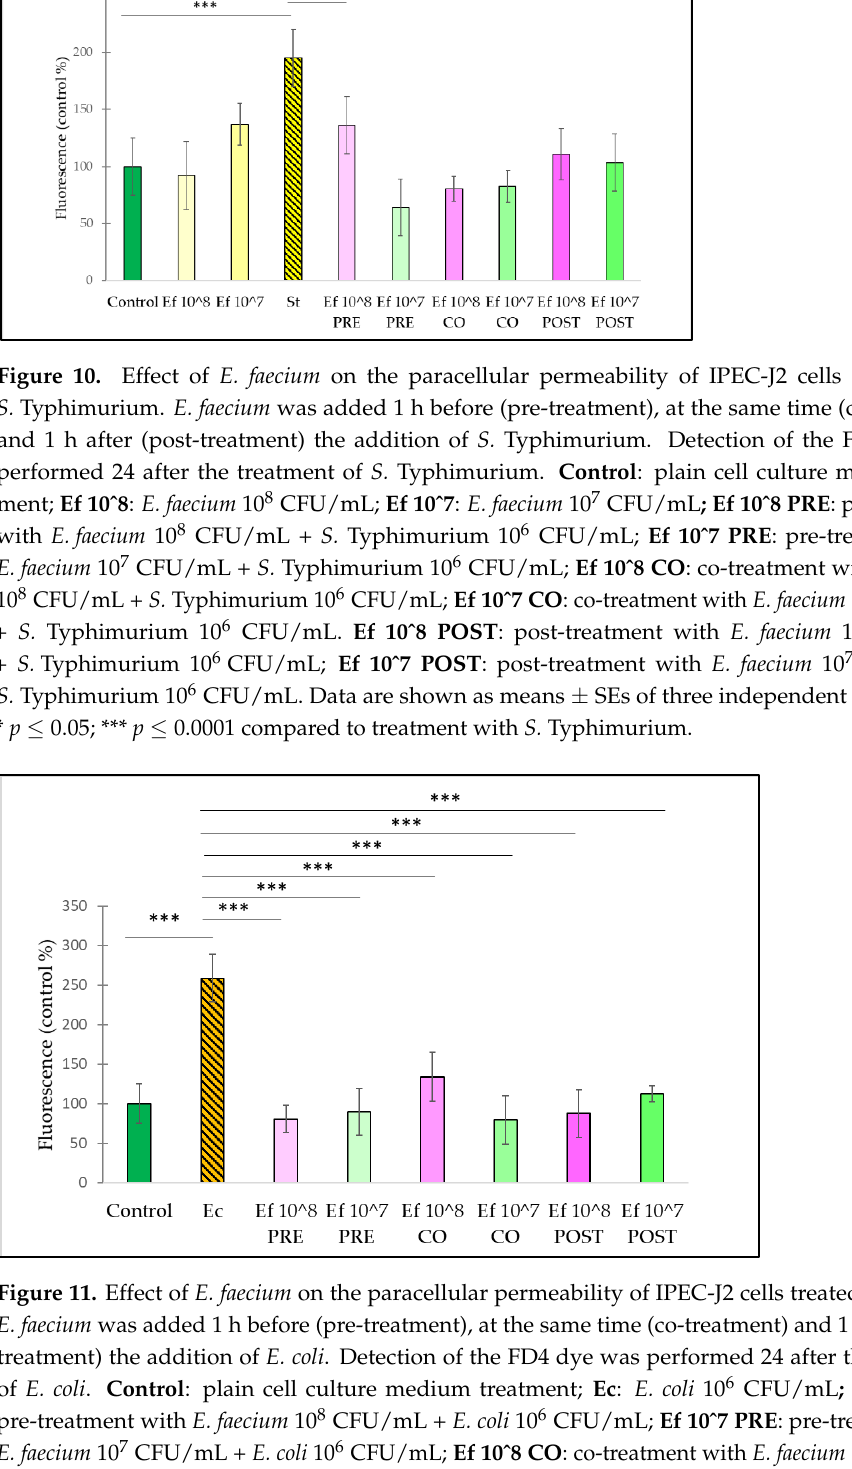
12 of 17 Figure 9. Inhibitory effect of E. faecium on E. coli and S. Typhimurium adhesion to IPEC-J2 cells. E. coli and S. Typhimurium adhesion inhibitions were determined upon incubation with E. faecium added 1 h before (pre-treatment), at the same time (co-treatment) and 1 h after (post-treatment) the addition of E. coli and S. Typhimurium, respectively. E. faecium was added in 10 8 CFU/mL. Ec : E. coli 10 6 CFU/mL ; Ef PRE : pre-treatment with E. faecium 10 8 CFU/mL + E. coli or S. Typhimurium 10 6 CFU/mL; Ef CO : co-treatment with E. faecium 10 8 CFU/mL + E. coli or S. Typhimurium 10 6 CFU/mL; Ef POST : post-treatment with E. faecium 10 8 CFU/mL + E. coli or S. Typhimurium 10 6 CFU/mL. Val- ues are presented as means ± SEs of four independent experiments. *** p ≤ 0.0001 compared to treat- ment with S. Typhimurium. *** p ≤ 0.0001 compared to treatment with E. coli . 3.5. The Effect of E. faecium on Paracellular Permeability of IPEC-J2 Cells Challenged by E. coli and S. Typhimurium After 24 h of pathogen exposure, the epithelial cell layer was partially disrupted. The fluorescence intensity measured in the basolateral compartment significantly increased (compared to the untreated control samples) when IPEC-J2 cells were treated with S.